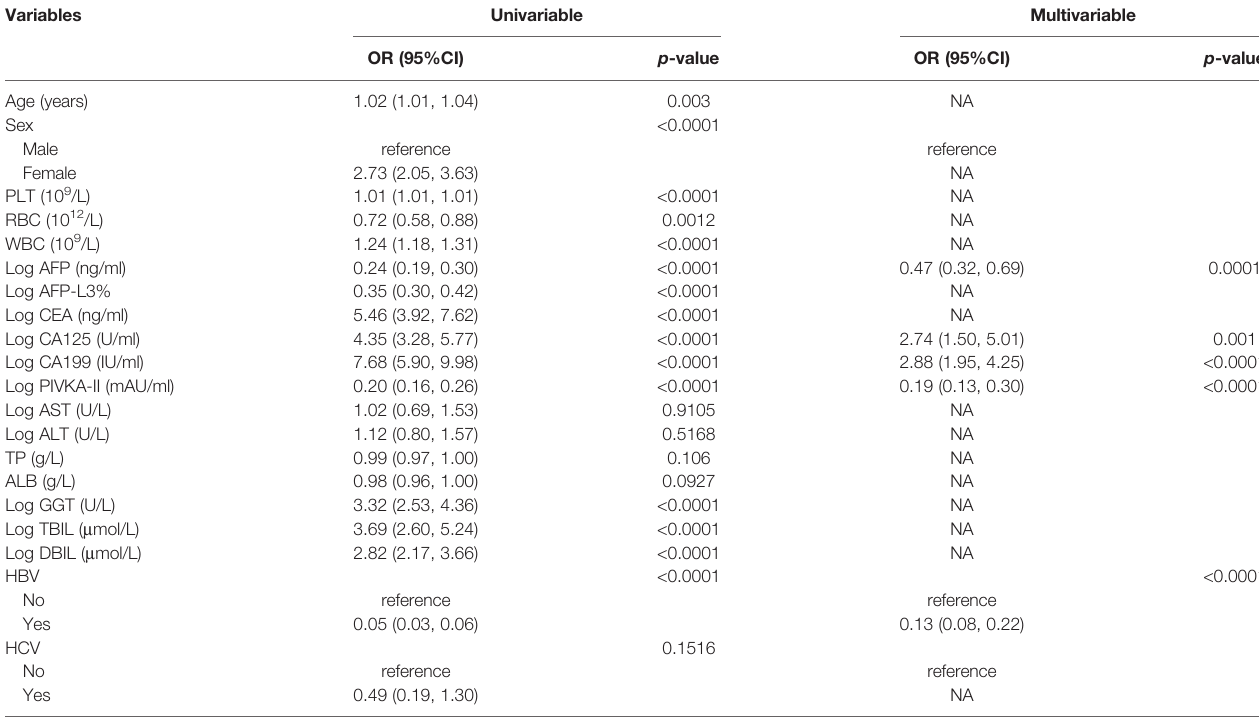
TABLE 3 | Univariate and multivariate logistic regression analysis of ICC presence based on preoperative data in training cohort.